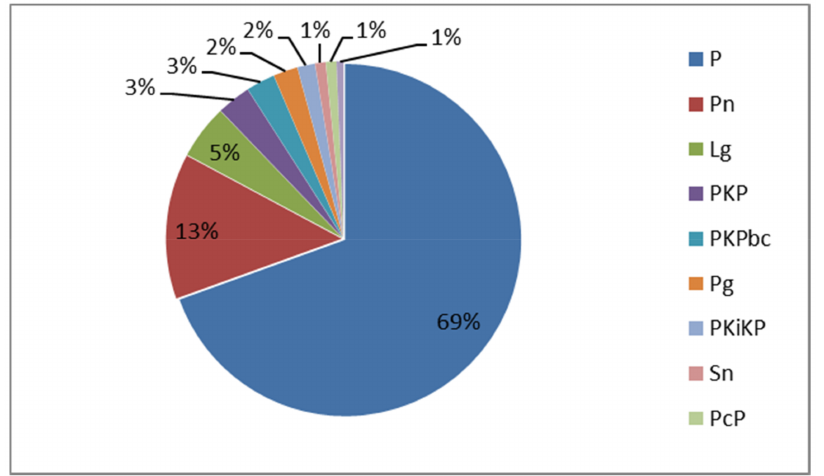
Figure 13. The distribution of top 10 phases of MKAR in 2019 half year